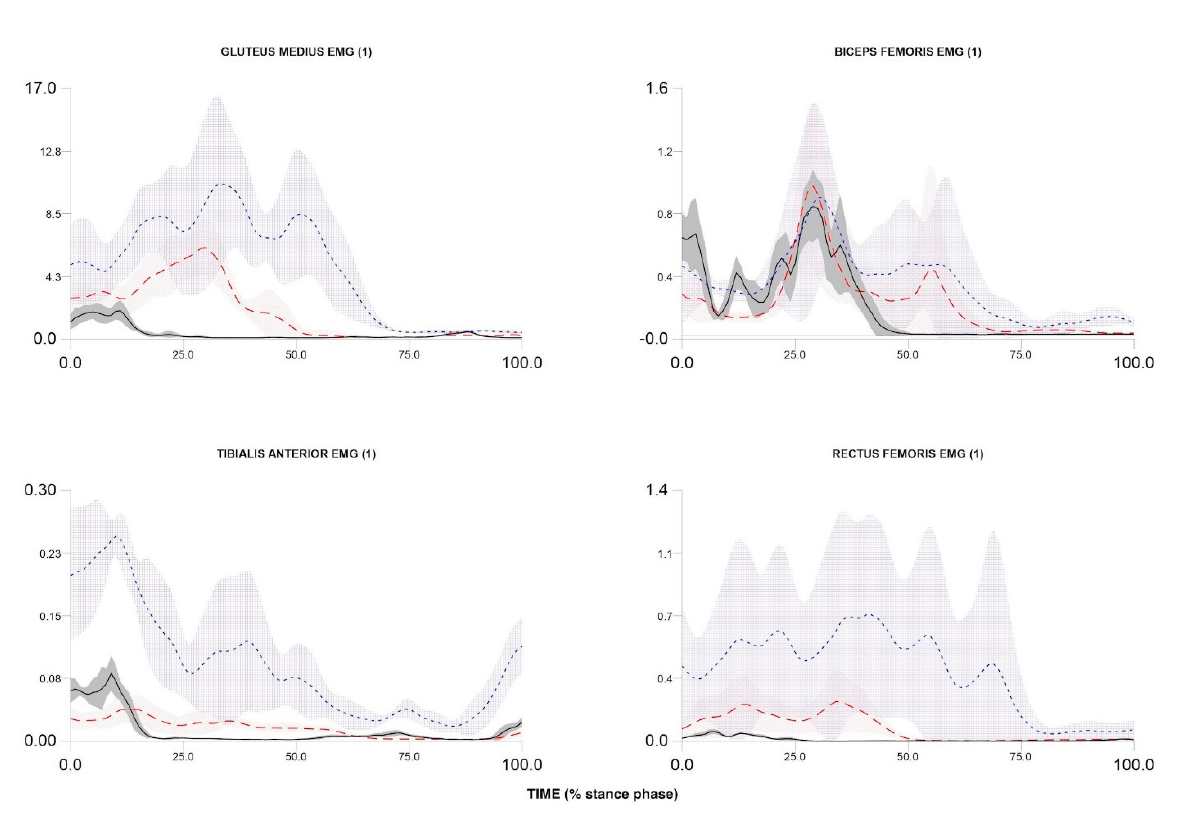
Figure 6. Electromyography activity during stance phase of walking, over-ground running and cutting maneuver in one participant. Over-ground running—red dash line; walking—black solid line; cutting maneuver—blue dot line.